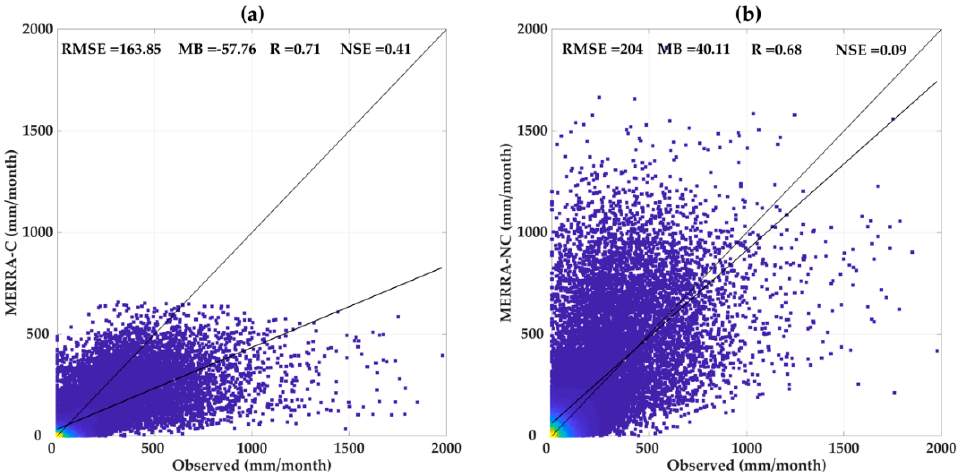
Figure 11. Scatterplot between observed, ( a ) MERRA-C, and ( b ) MERRA-NC generated by monthly datasets at all stations between 2000 and 2018 across the study area. The unit of the figure metrics is in mm/month.